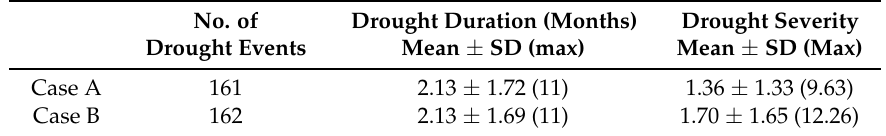
Table 4. Statistics of meteorological droughts obtained from two different processing